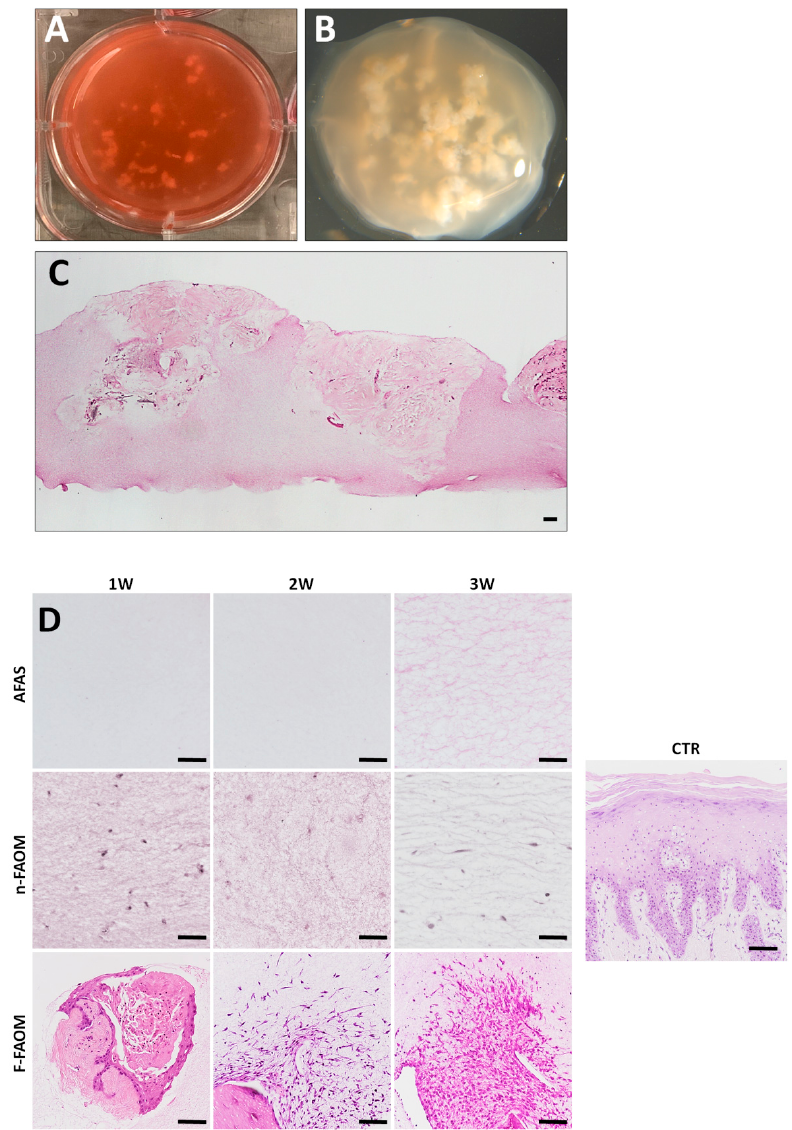
Figure 1. In vitro development of functionalized fibrin–agarose oral mucosa substitutes (F-FAOM). ( A , B ) Macroscopic images of functionalized F-FAOM. ( C ) Histological evaluation of F-FAOM stained with hematoxylin eosin. Scale bar: 100 µm. Analysis of controls and biofabricated oral tissues using hematoxylin and eosin staining ( D ). CTR: control native oral mucosa; AFAS: acellular fibrin–agarose scaffolds; n-FAOM: non-functionalized fibrin-agarose oral mucosa stroma substitutes using isolated primary cell cultures of human oral mucosa fibroblasts immersed in fibrin–agarose scaffolds; F-FAOM: functionalized fibrin–agarose oral mucosa stroma substitutes using oral mucosa tissue explants directly immersed in fibrin–agarose scaffolds. 1W: samples kept in vitro 1 week; 2W: samples keep in vitro 2 weeks; 3W: samples keep in vitro 3 weeks. Scale bars: 100 µm.